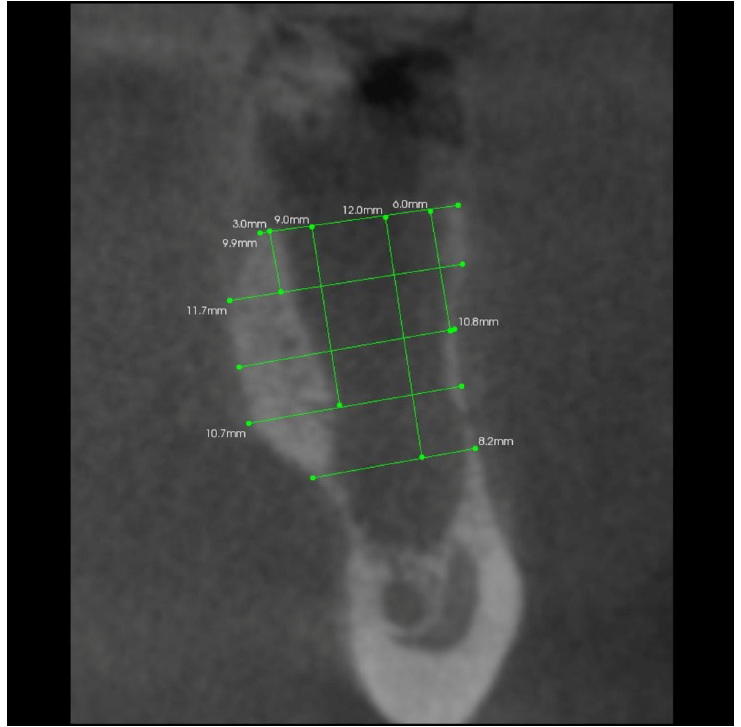
Figure 7. Transverse imaging of mandibular alveolus obtained from CBCT. The alveolus width measurement 10 days post-extraction.